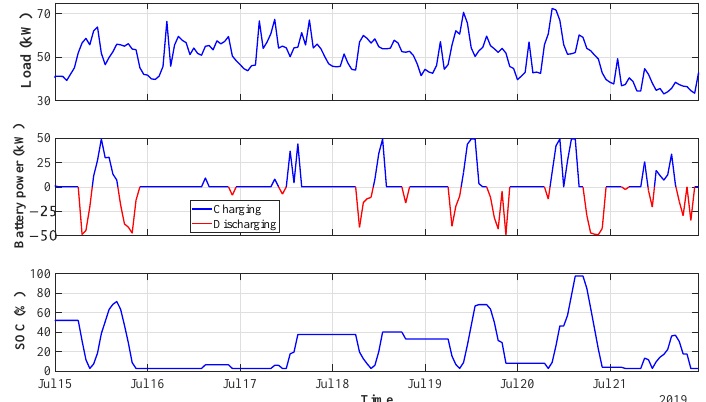
Figure 11. Marina’s load and BESS with bidirectional power flow strategy.